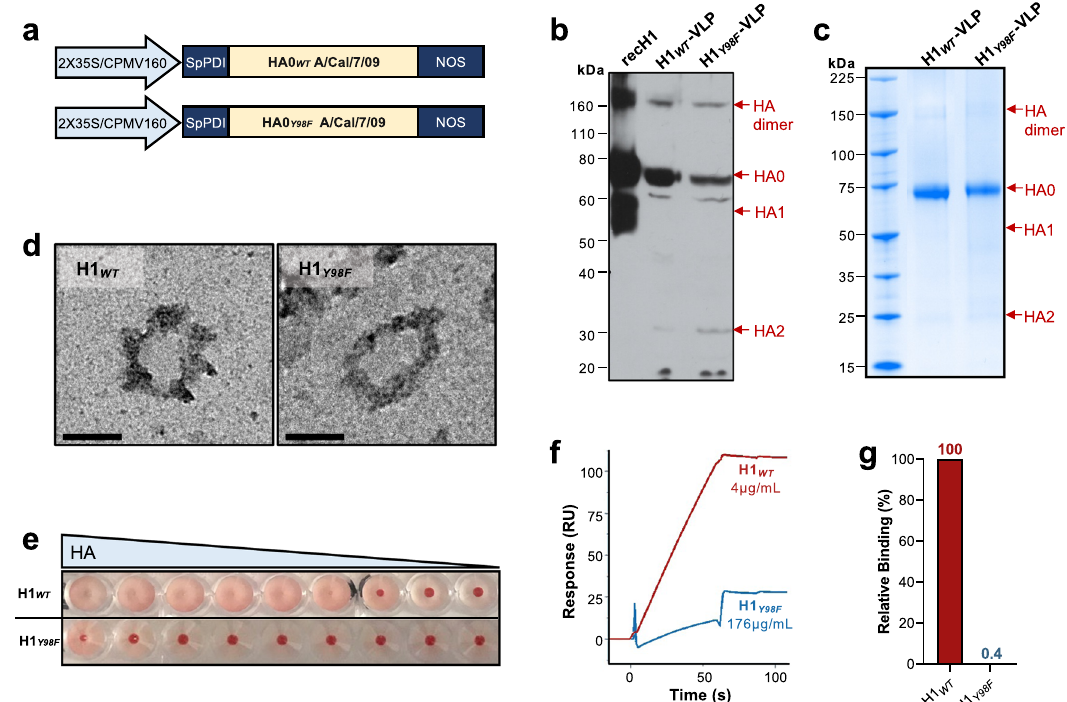
Fig. 1 Y98F mutation abrogates SA binding without affecting HA expression or VLP structure. Wild-type (WT) H1 (H1 WT ) and Y98F H1 (H1 Y98F ) were expressed in Nicotiana benthamiana . a Representation of the H1 WT (top) and H1 Y98F (bottom) expression cassettes. 2X35S/ CPMV160 promoter, double 35S promoter fused to the 5 ′ UTR of a cowpea mosaic virus (CPMV) expression enhancer; SpPDI signal peptide from alfalfa protein disul fi de isomerase, NOS nopaline synthase terminator signal. b Expression of HA was con fi rmed by SDS-PAGE of crude leaf extracts followed by immunoblot analysis. Commercially available recombinant H1 expressed in HEK-293 cells (recH1, Immune Technologies) was included as a positive control (1 µg). 1° ab: rabbit polyclonal anti-H1 1:500 (Cat. No. IT-003-SW, Immune Technology); 2° ab: horseradish peroxidase-conjugated goat anti-rabbit IgG 1:20000 (Cat. No. IT-200-01, Immune Technology). c VLP composition and purity were evaluated by SDS-PAGE of puri fi ed leaf digests followed by Coomassie G-250 staining. d Representative TEM images show the similar size and morphology of H1 WT - and H1 Y98F -VLP. Images were acquired using a Tecnai G2 Spirit transmission electron microscope. Scale bar = 100 nm. e Sialic acid (SA) binding was evaluated based on hemagglutination of turkey red blood cells following incubation (30 min) with serial two- fold dilutions of H1 WT - and H1 Y98F -VLP (starting at 1:150 and 1:10, respectively). SA binding was further quanti fi ed by SPR. f SPR sensorgram showing the binding response of H1 WT - (red) and H1 Y98F -VLP (blue) to α -2,6 SA captured on a streptavidin-coated chip surface. g Relative binding of H1 Y98F -VLP when adjusted for HA